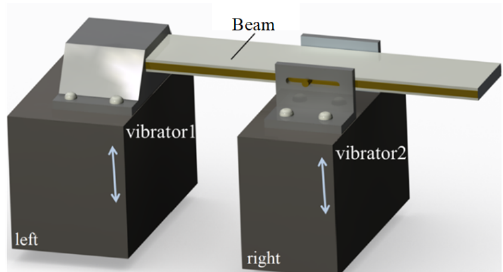
Figure 2. Physical model of the piezoelectric energy harvester for human body motion subjected to two